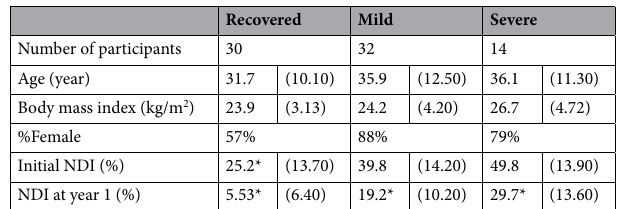
Table 1. Descriptive statistics from study participants, grouped by clinical outcome. Outcome was determined by Neck Disability Index (NDI) percentage scores. * p < 0.001.